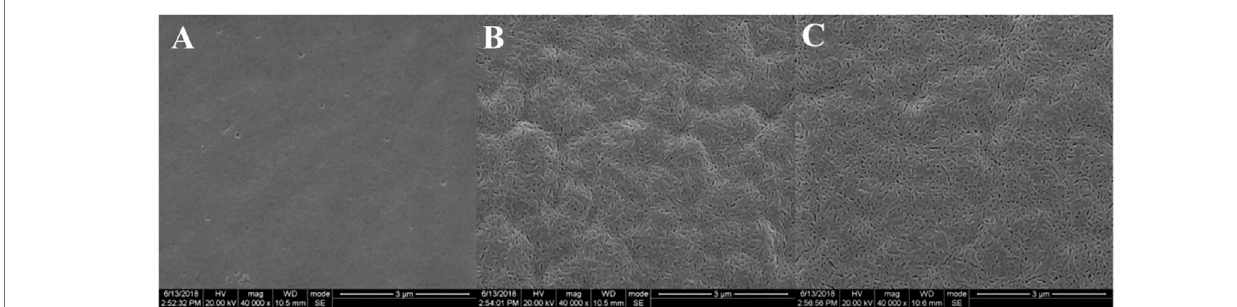
Frontiers in Energy Research |